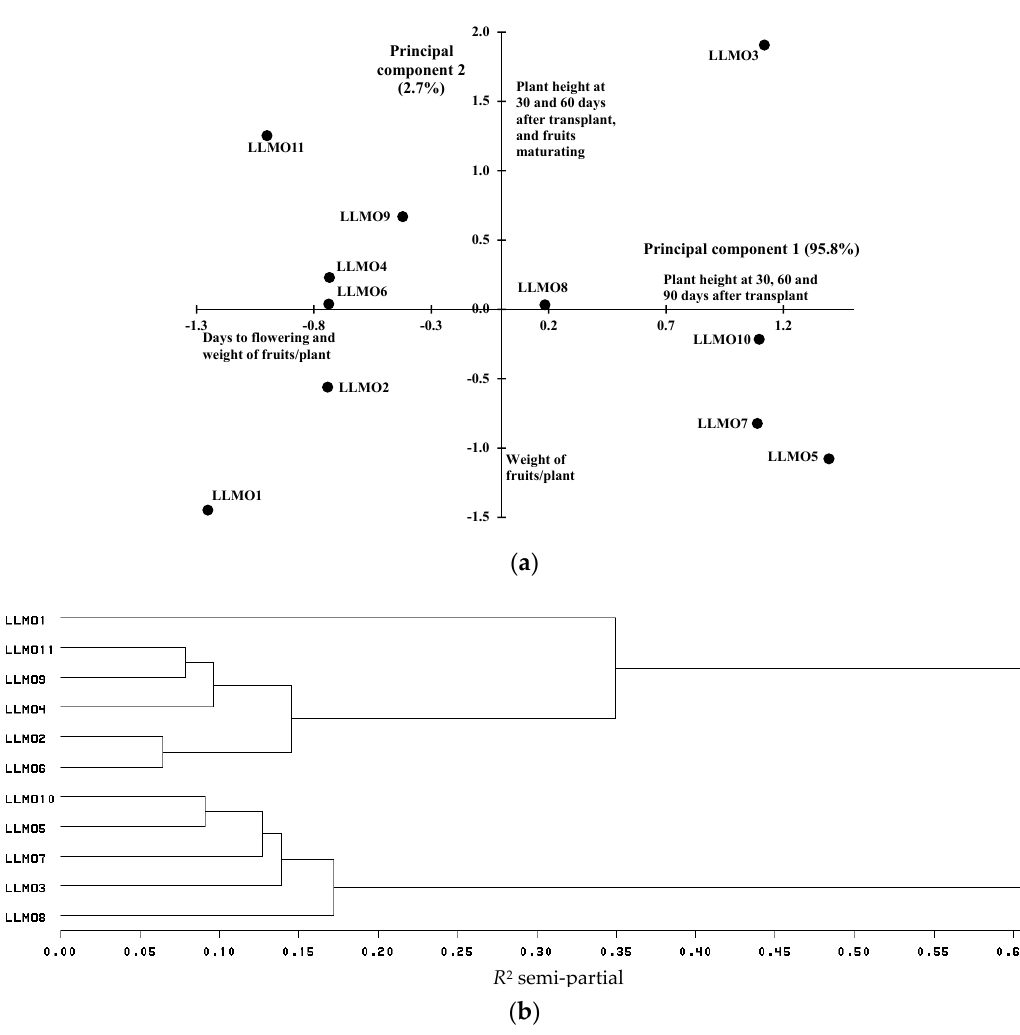
Figure 1. Dispersion of tomato accessions from El Salvador, based on two first principal components ( a ) with variables associated to higher eigenvector values, and ( b ) with hierarchical clustering by Ward’s method, with regard to agromorphological traits.